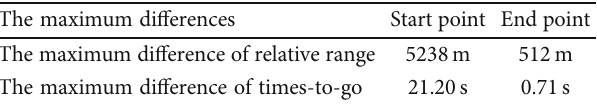
Table 3: Summary of the di ff erences of times-to-go and relative range with delay τ = 0 : 2s